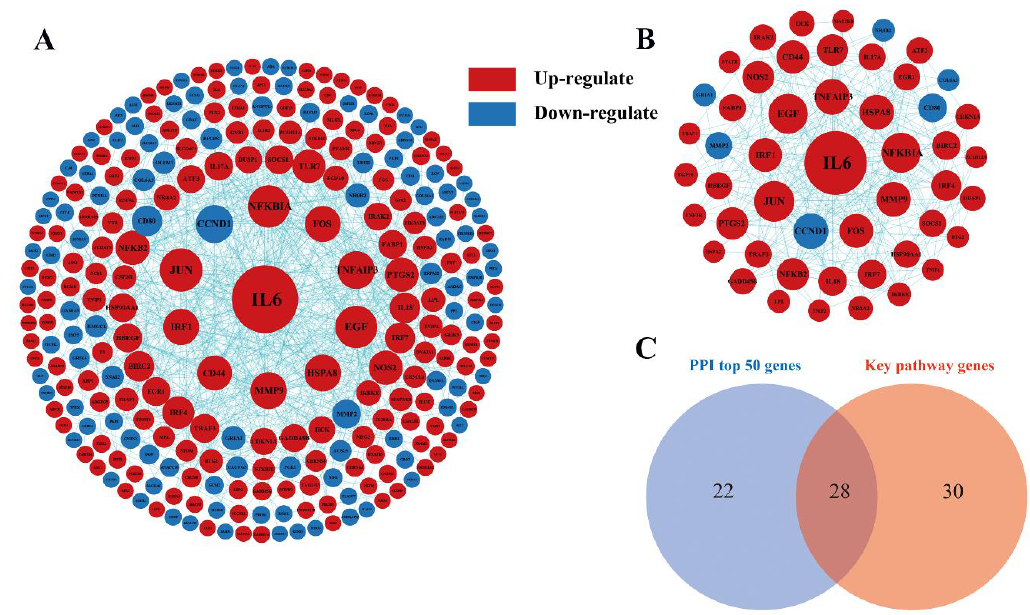
Figure 6. Interaction of differentially expressed gene protein network. ( A ) Protein–protein interaction network (PPI). ( B ) The network of 50 key genes. The red dot represents upregulation, the blue represents downregulation, and the size of the dot represents the size of the degree. The larger the dot, the stronger the significance. ( C ) The intersection of top 50 PPI genes with key pathway genes. Table 4. The 28 key genes in the intersection of top 50 PPI genes with key pathway genes. Gene Symbol Degree Gene Symbol